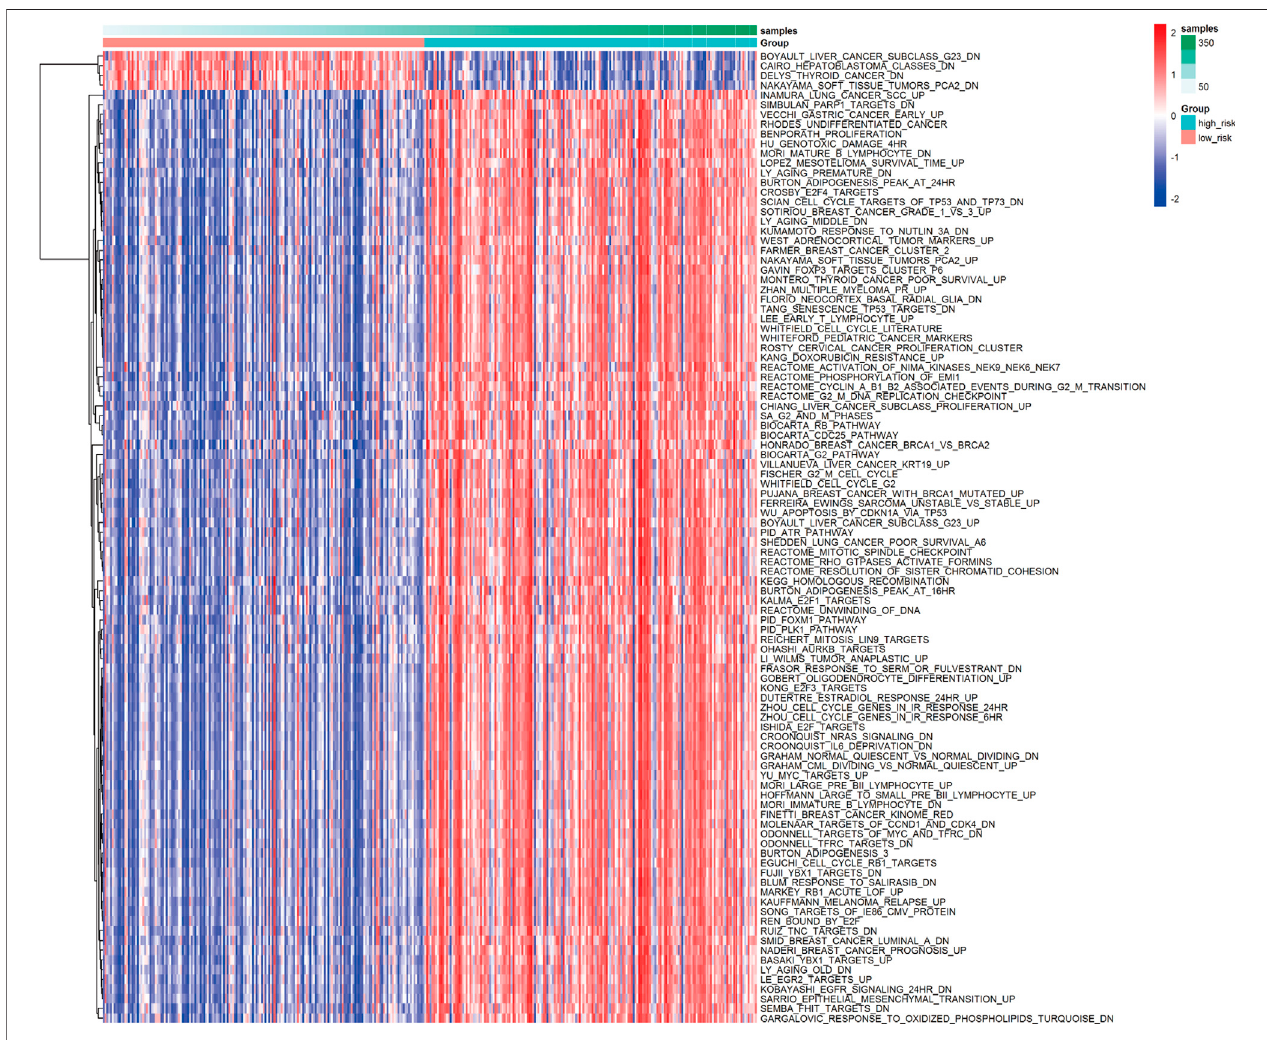
FIGURE 6 | Different pathways between the high-risk and low-risk groups.